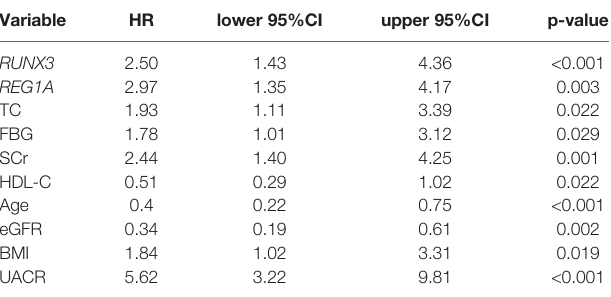
TABLE 4 | Univariate COX regression of diagnostic markers and clinical characteristics.